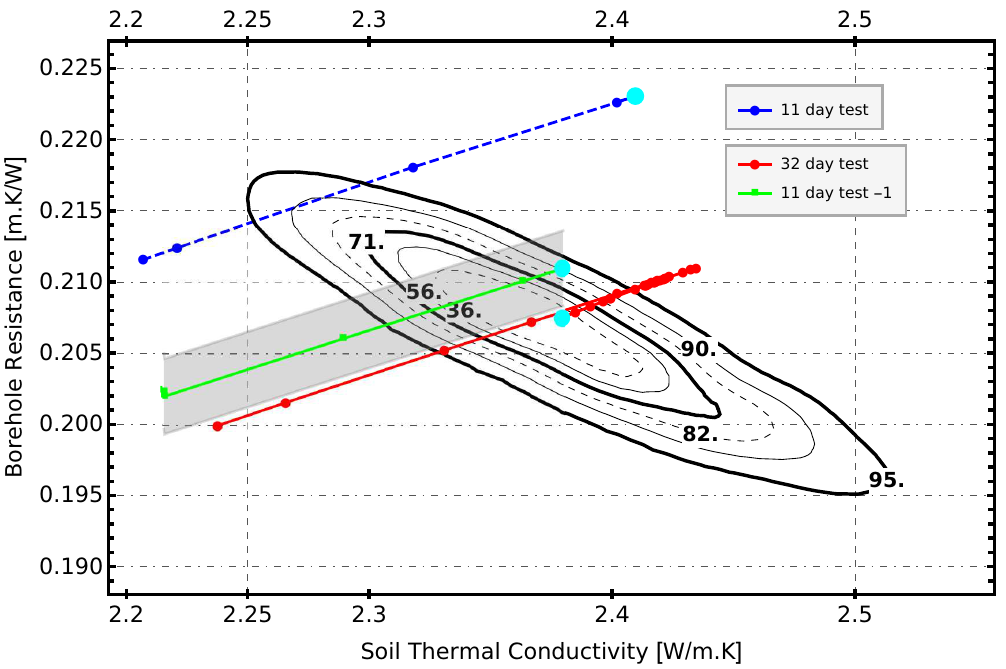
Figure 9. Combination of probability density regions (Figure 5) and ( λ − R b ) estimation trajectory for the 32-day test (red line), the original 11-day test (blue line), and the 11-day test with –1-day data (green line). The cyan circles show the estimated final values for each test. The gray filled region around the 11-day with –1-day test trajectory shows the result of the estimation if the undisturbed ground temperature would have been taken ± 0.1 K around the estimated value of 20.12 ◦